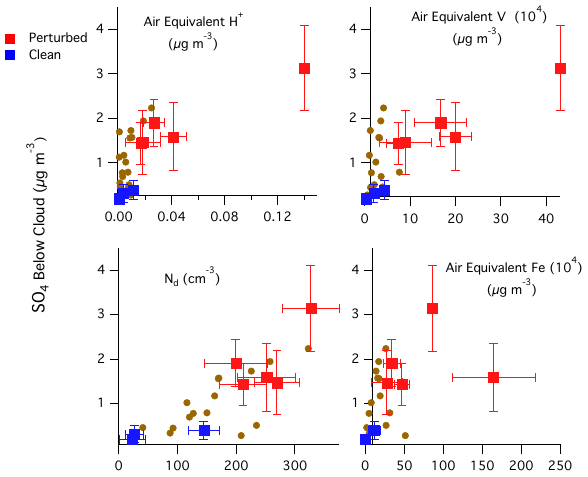
Fig. 7. Trends in below cloud sulfate vs. air equivalent H + , cloud droplet number concentration ( N d ), air equivalent V and air equiv- alent Fe. Iron and vanadium were measured in cloud water samples using ICP-MS. Hydronium concentrations were calculated based on cloud water sample pH. Air equivalent units are calculated as the product of the concentration of a species in a bulk cloud water sam- ple and the average liquid water content measured during the cloud water collection period. Each point represents a single flight. Clean flights (RF 5–8) are colored blue while perturbed flights (RF 14–18) are colored red. Error bars show the standard deviation of each mea- surement. The remainder of the flights are shown as brown